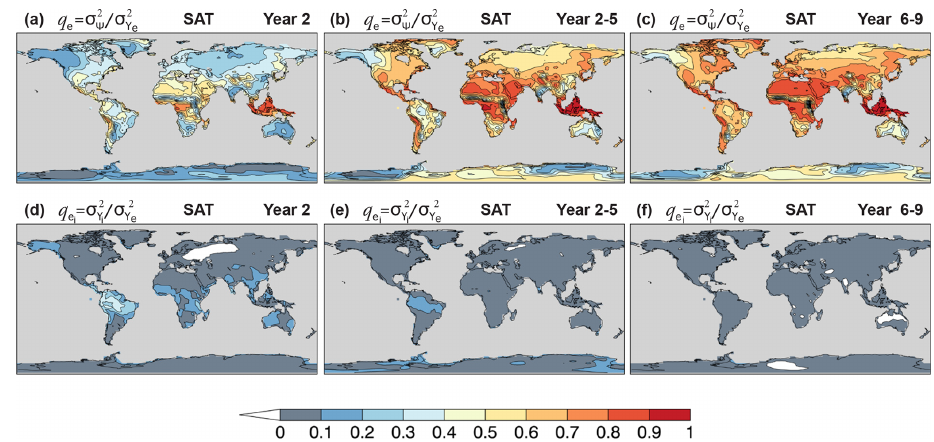
Figure 9. Potential predictability of CanESM5 annual and multi-year mean near-surface air temperature hindcasts. (a–c) Potentially pre- dictable variance fraction q e = σ 2 (b, e) Year 2–5, and (c, f) Year 6–9.